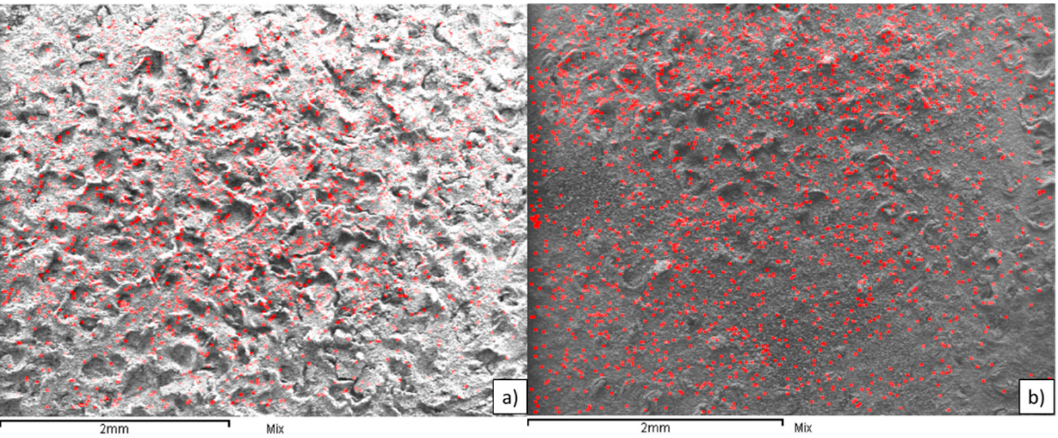
Figure 5. EDS Mapping of ( a ) Ir/CeO 2 ; and ( b ) Ir/La 2 O 3 . Table 2. Metal concentration on catalysts (wt Table 2. Metal concentration on catalysts (wt %).